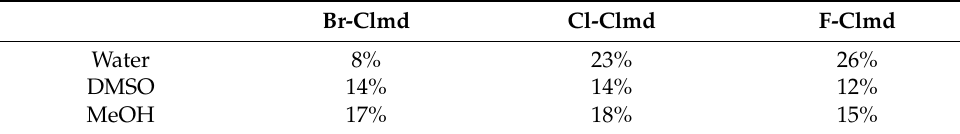
Table 1. Fluorescence quantum yields (QY, in %) in different solvents. Br-Clmd Cl-Clmd F-Clmd Water 8% 23% 26%